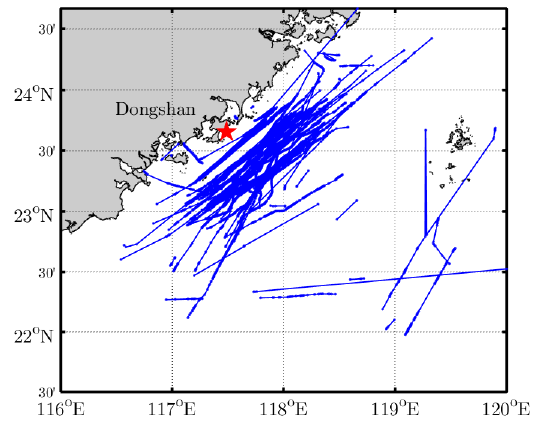
Figure 5. The radar site location (red star) and AIS track of ships (blue lines) on 25 September 2015.